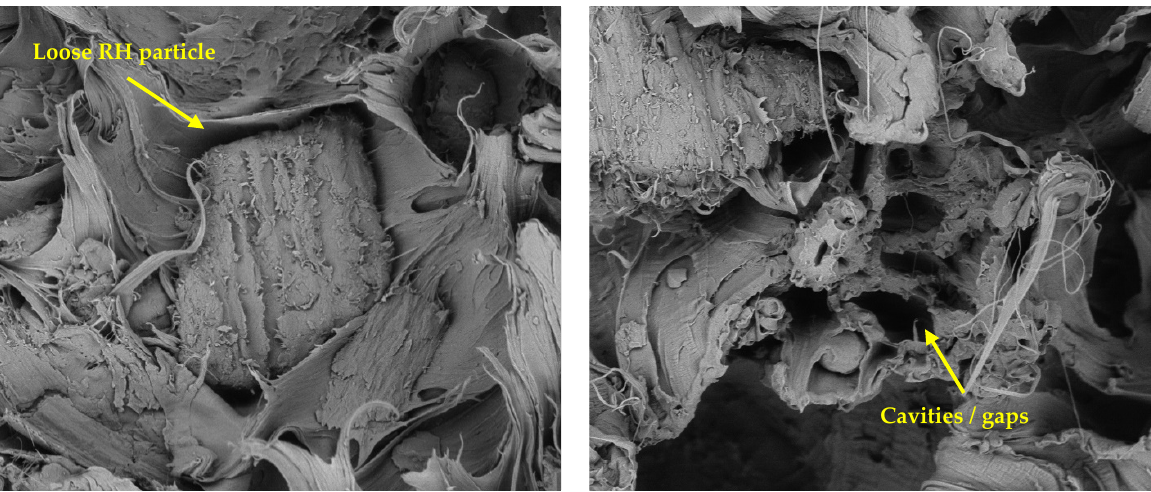
Figure 10. SEM micrographs for reinforced composite rHDPE/RH 3 1000× magnification.